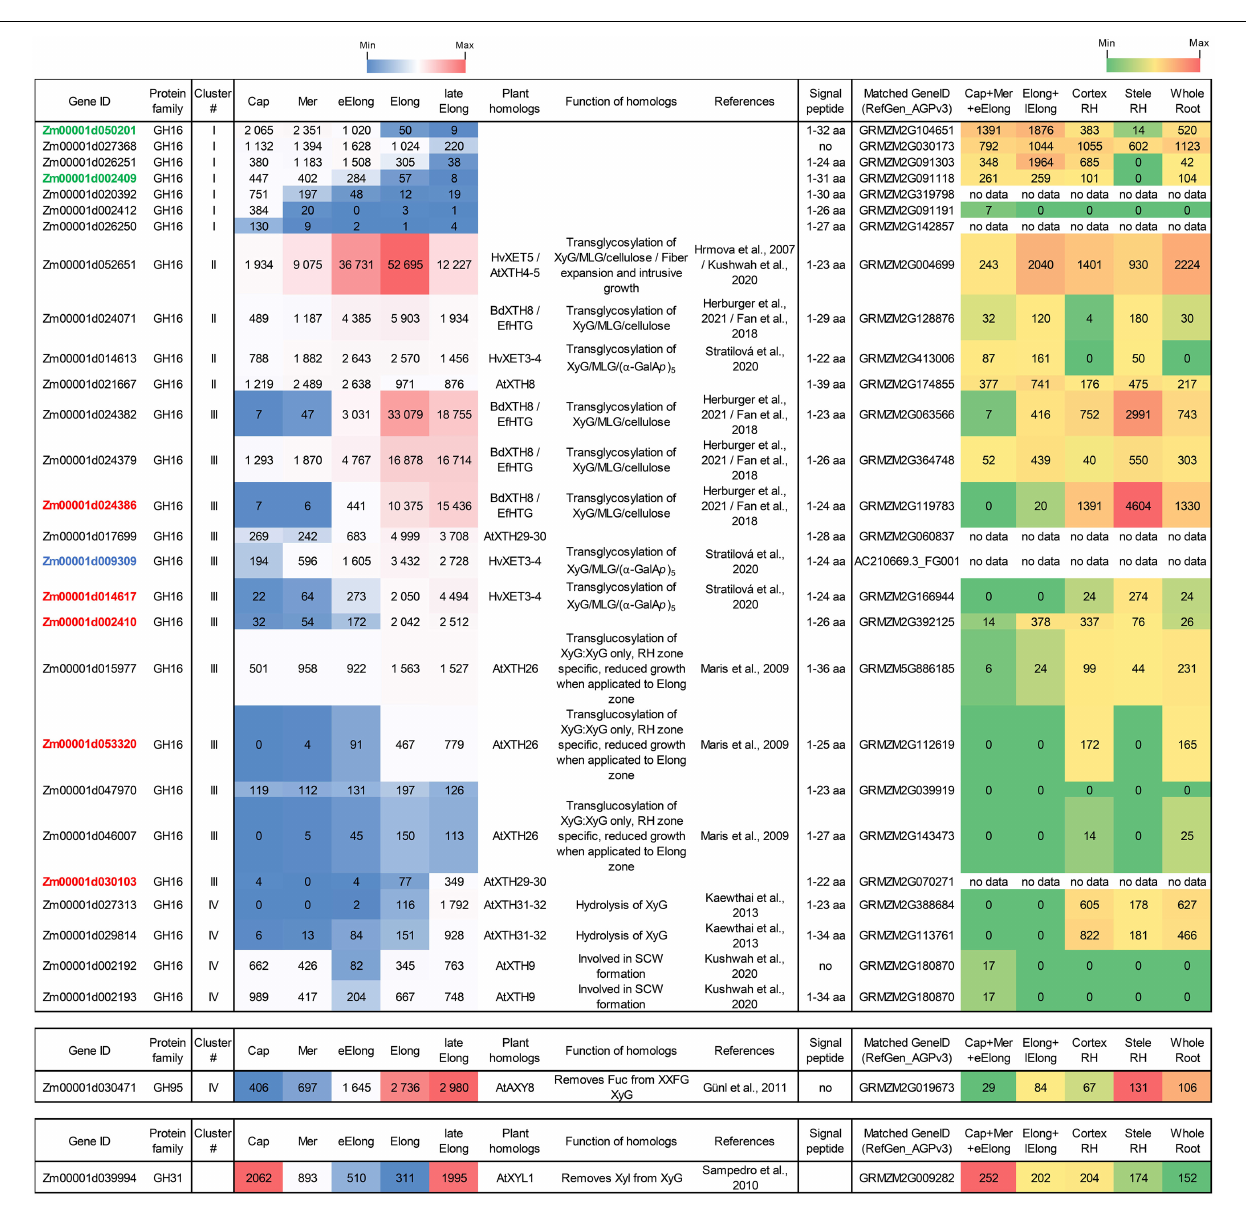
FIGURE 6 | Expression of maize genes encoding putative xyloglucan endotransglucosylases/hydrolases (XTHs) of GH16 in maize roots. The level of transcripts (TGR, red-blue heat map) and abundance of corresponding proteins (averaged and normalized total spectral counts (Marcon et al., 2015), red-green heat map) of genes encoding putative XyG endotransglycosylases/hydrolases of the GH16 protein family in various zones of maize roots. Genes with expression values below 100 in all the studied samples are not shown. TGR values are sorted from maximum to minimum within each cluster. Maize genes co-expressed with primary and secondary cell wall cellulose-synthases, and the XyG backbone synthase are labeled in blue, red, and green, respectively. XyG, xyloglucan; MLG, mixed-linkage glucan; SCW, secondary cell wall, Cap, root cap; Mer, meristem; eElong, early elongation zone; Elong, zone of active elongation; lateElong, zone of late elongation before root hair initiation; RH, root hair zone; no data, no corresponding peptides were found by Marcon et al. (2015) proteomics